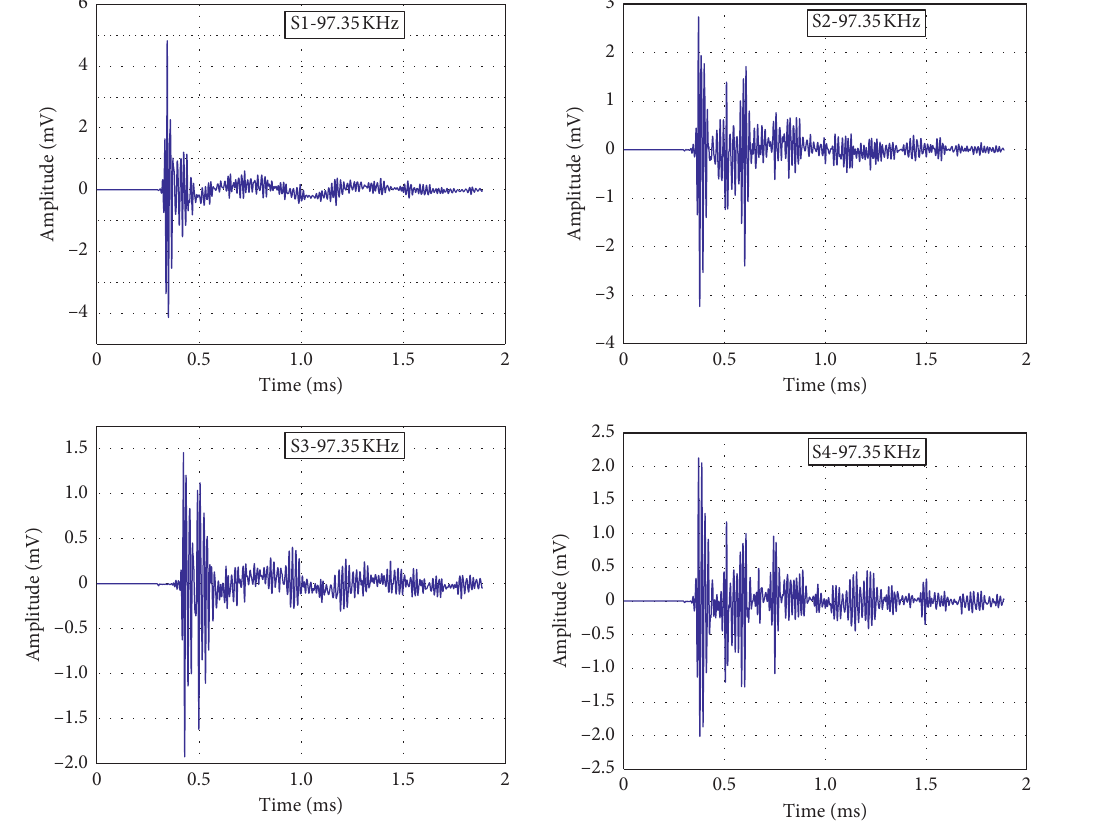
Figure 14: Wavelet decomposition waveform at frequency band (4,